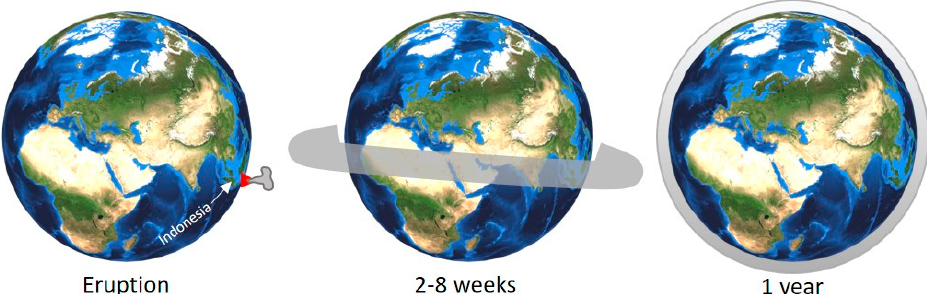
Figure 6. Schematic development of volcanic gases after the eruption of Tambora in 1815; 2–8 weeks: Sulfur gases had circled the equator and reached the stratosphere, then oxidized to sulfate aerosols; 1 year: aerosols had widely spread and moved poleward (after Ref. [79]).